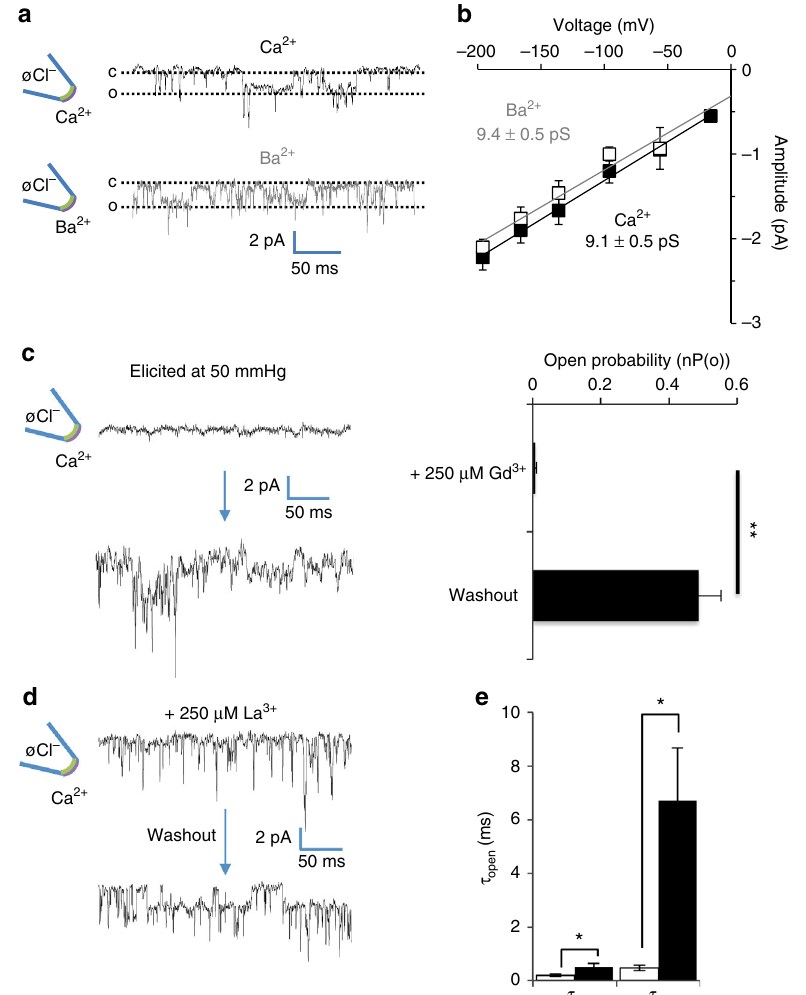
Fig. 2 The mechanically activated RMA current is preferentially permeable to Ca 2+ and affected by both the mechanosensitive channel inhibitor Gd 3+ and the calcium channel blocker La 3+ . a Representative single channel recordings in response to positive pressure, in an outside-out patch con fi guration with Ca 2+ ( top ) or Ba 2+ ( bottom ) as the permeant bivalent cation in the bath. The dotted lines indicate the open ( O ) and closed ( C ) channel state; b Single channel I/V curves show similar conductance with permeant cations Ca 2+ ( solid square ) and Ba 2+ ( open square ). Values are means ± SE ( n = 6); c The mechanically activated RMA current is inhibited by Gd 3+ and restored after wash-out ( left, n = 6) and the corresponding open probability (nP(o), right ). Values are means ± SE; d Representative recording showing the effect of La 3+ ( left , n = 6) on the RMA current; e La 3+ ions affects the open state of